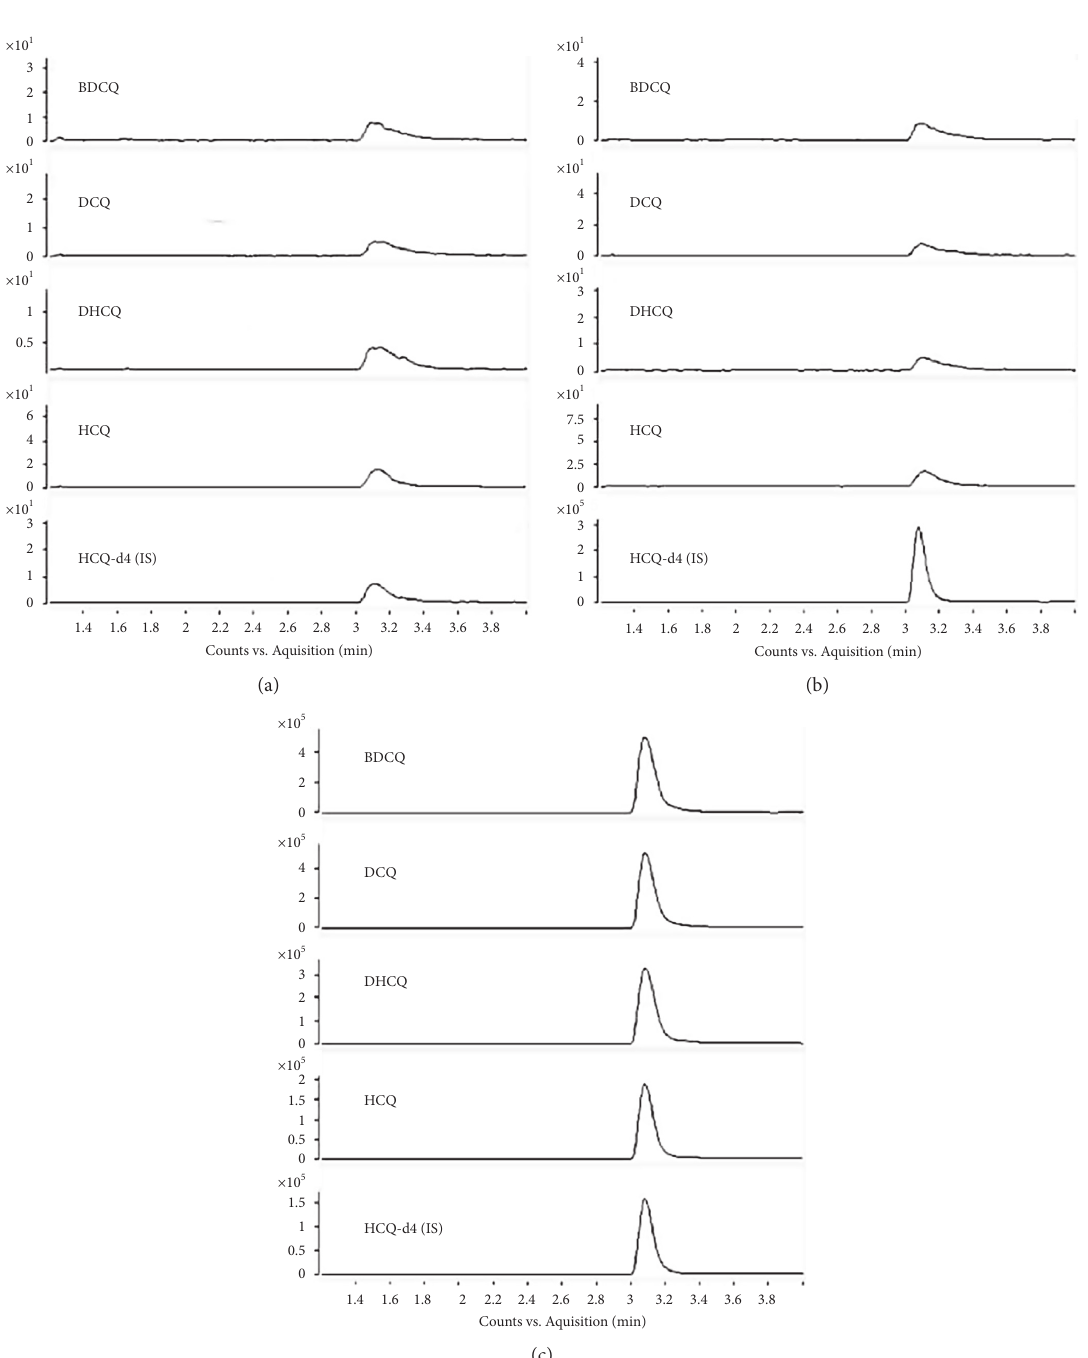
Figure 2: Typical MRM chromatograms of (a) blank rat blood; (b) blank blood spiked with 80ng/mL IS; (c) real rat blood